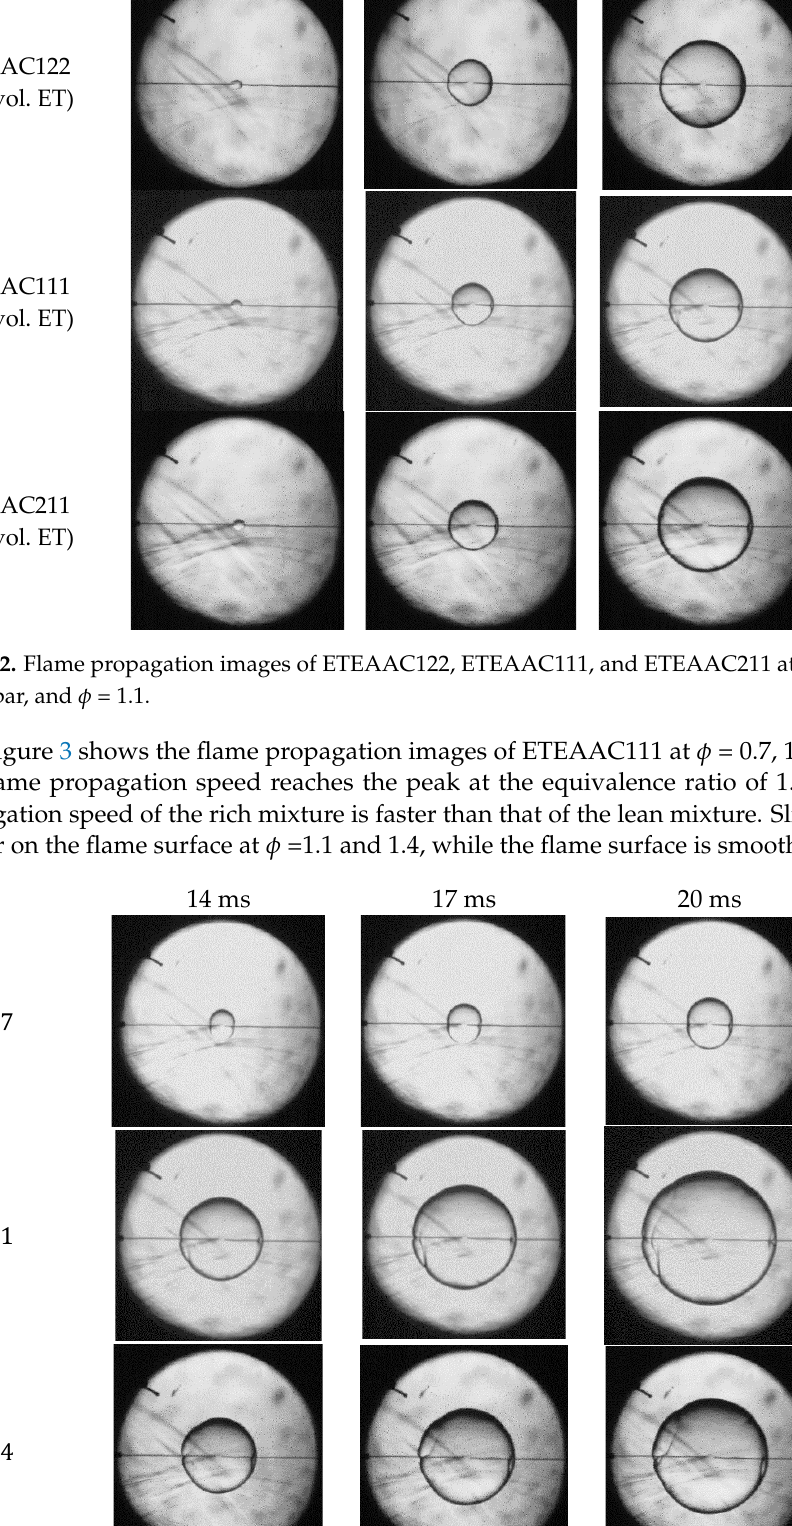
Figure 3. Flame propagation images of ETEAAC111 at T 0 = 358 K, P 0 = 1 bar, and ϕ = 0.7, 1.1 and 1.4.